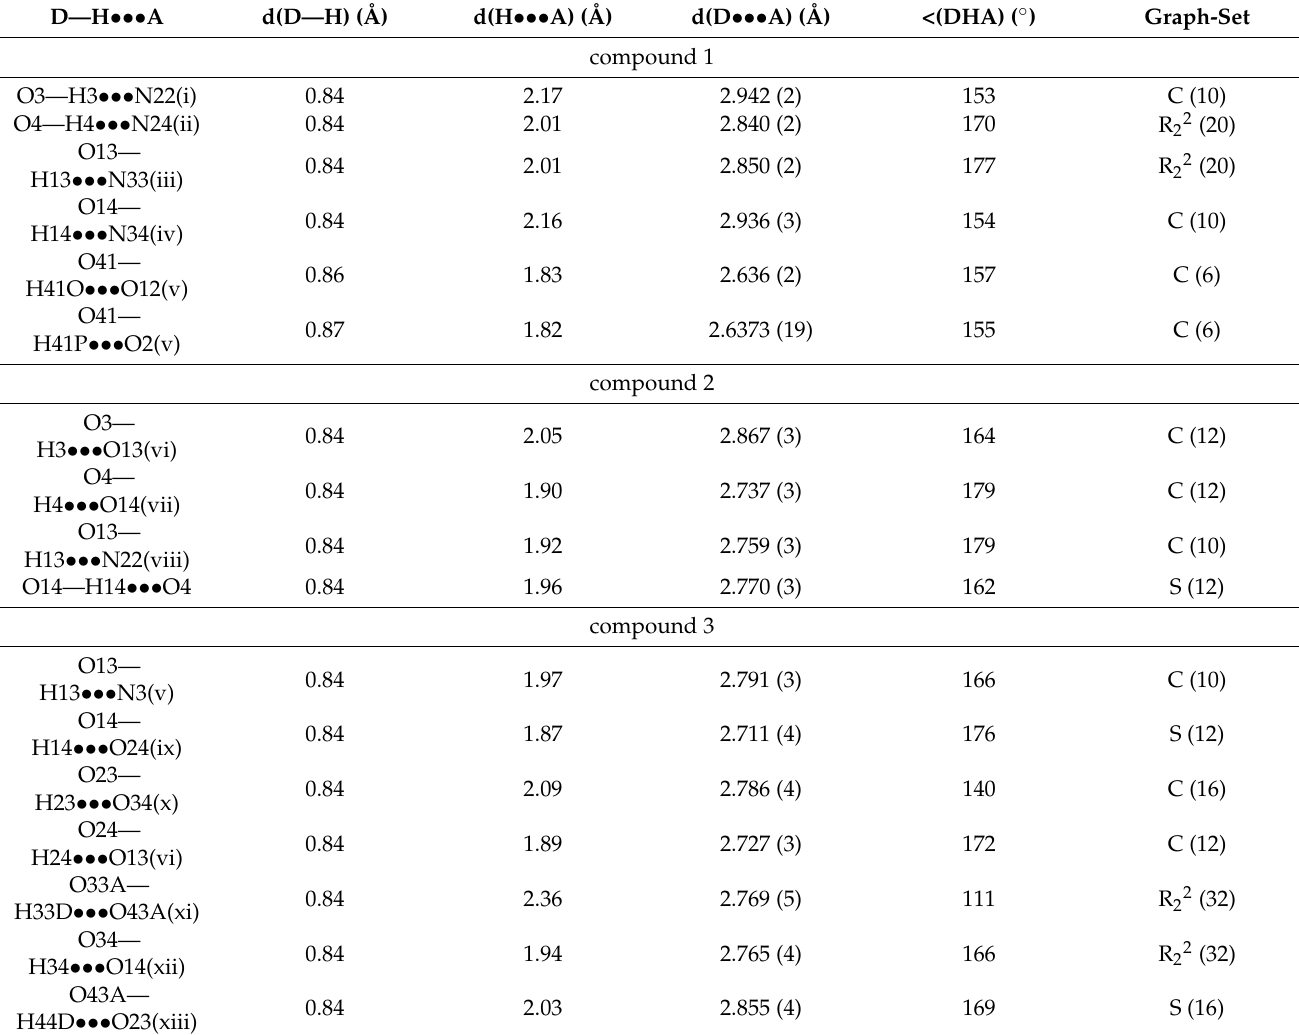
Table 2. Hydrogen bonds in the studied